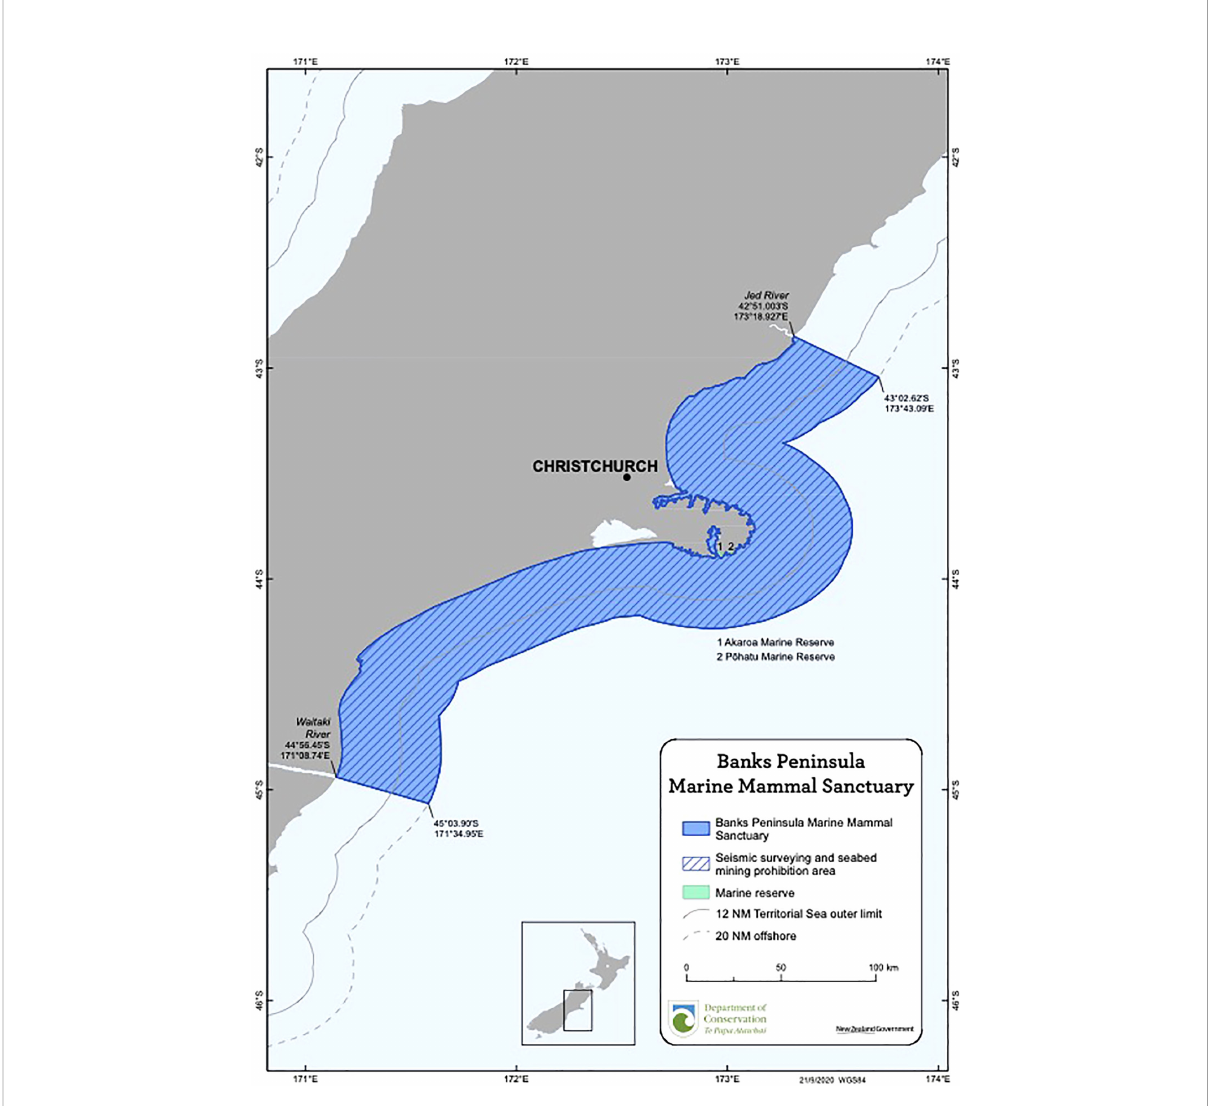
FIGURE 4 Map of the Banks Peninsula Marine Mammal Sanctuary. Source: Doc.govt.nz,